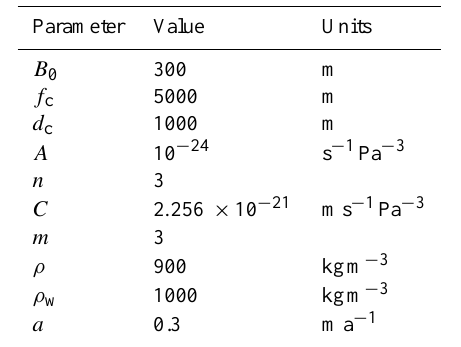
the surface accumulation is in units of ice equivalent, and the actual mass flux across the surface is ρa = 270 kg a − 1 m − 2 .